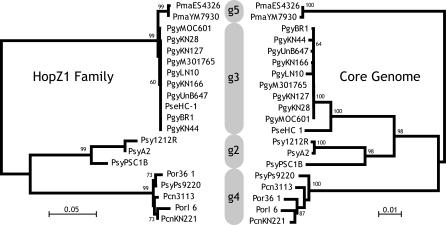
Congruence between the HopZ1 Gene Genealogy and the MLST Core Genome Phylogeny of P. syringae
See Figures 2 and S1 for details on the phylogenetic methods used. Gray areas labeled g2–g5 in the center of the figure indicate the major phylogroups as determined by MLST. Bootstrap support values (>60%) are indicated above nodes.